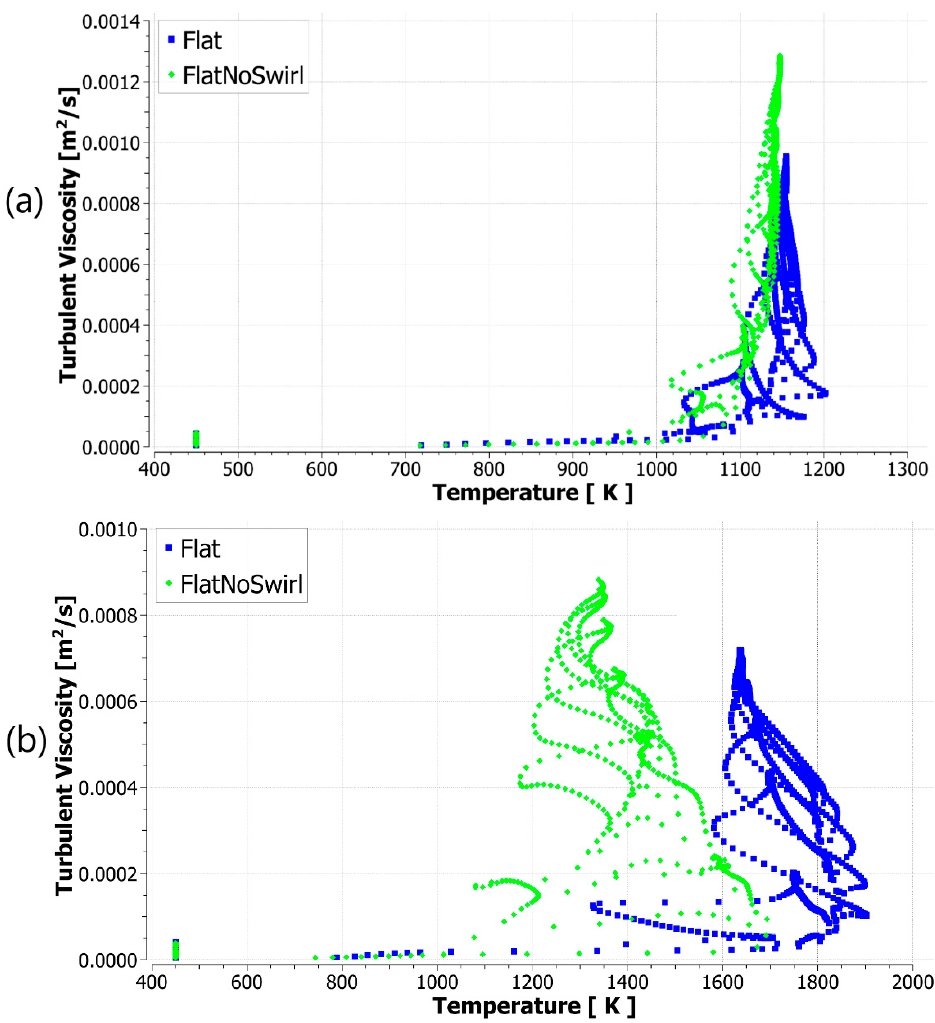
Figure 13. Comparison between the scatter plots of the turbulent diffusivity as a function of gas temperature for the cases with and without swirl: ( a ) 5 CAD BTDC; ( b ) 5 CAD ATDC.